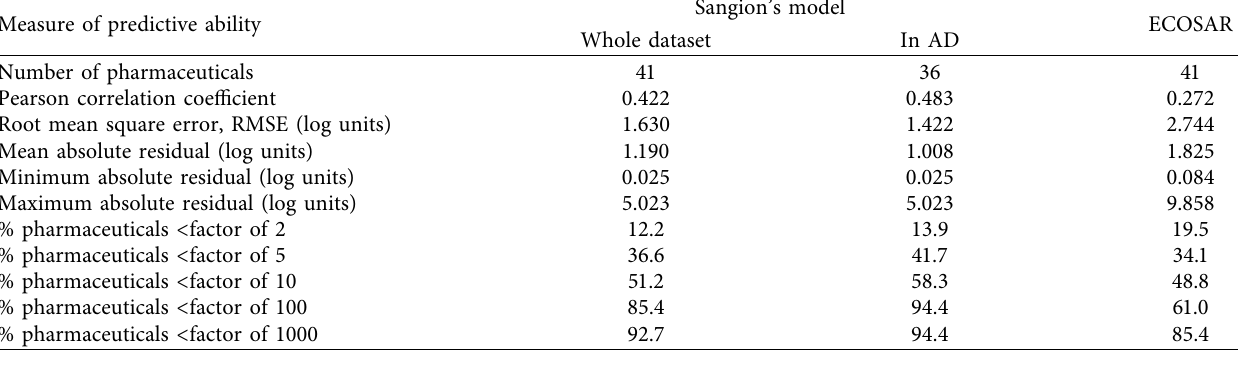
Table 1: Summary statistics for performance comparison of Sangion’s model versus ECOSAR.